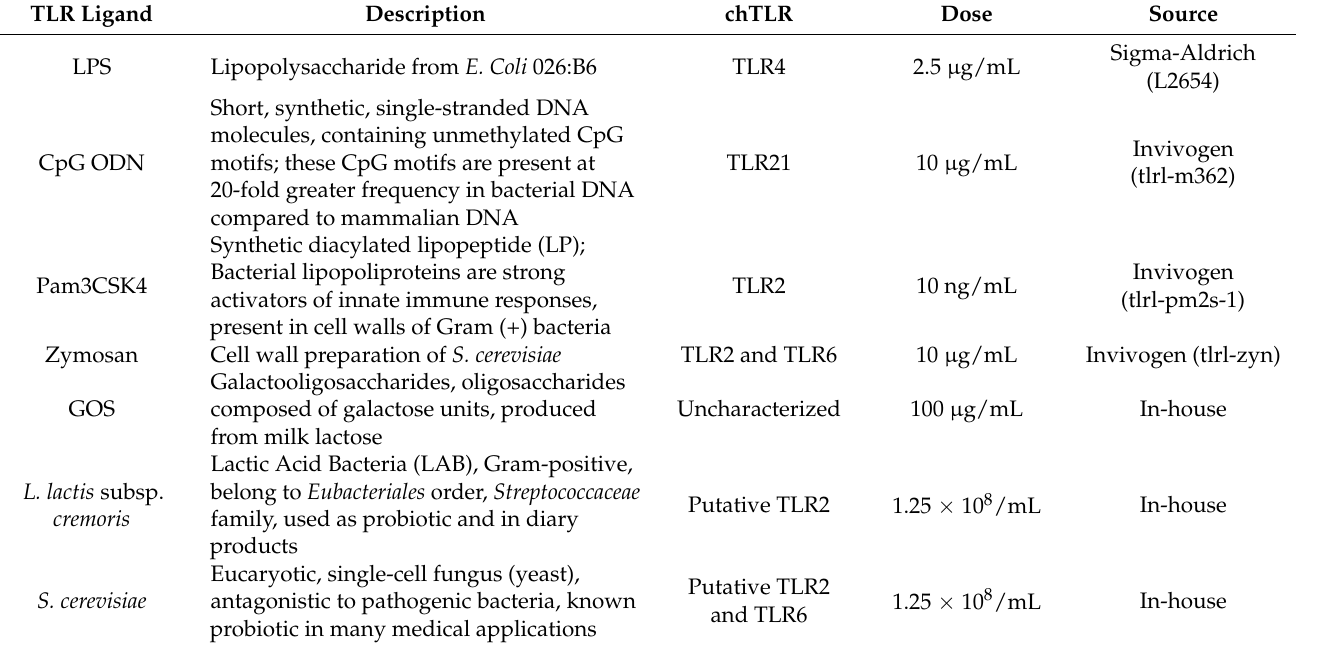
Table 1. Toll-like receptor (TLR) ligands and live probiotics are used to stimulate chicken peripheral blood mononuclear cells (PBMC) in